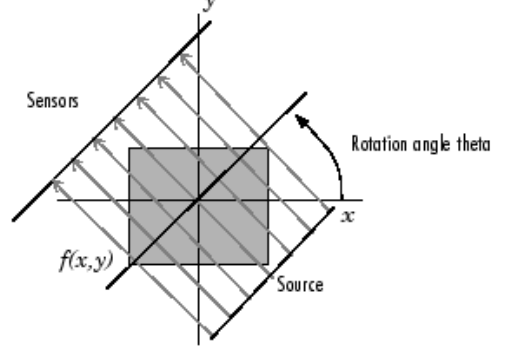
Figure 1. Schema of the projection with parallel paths